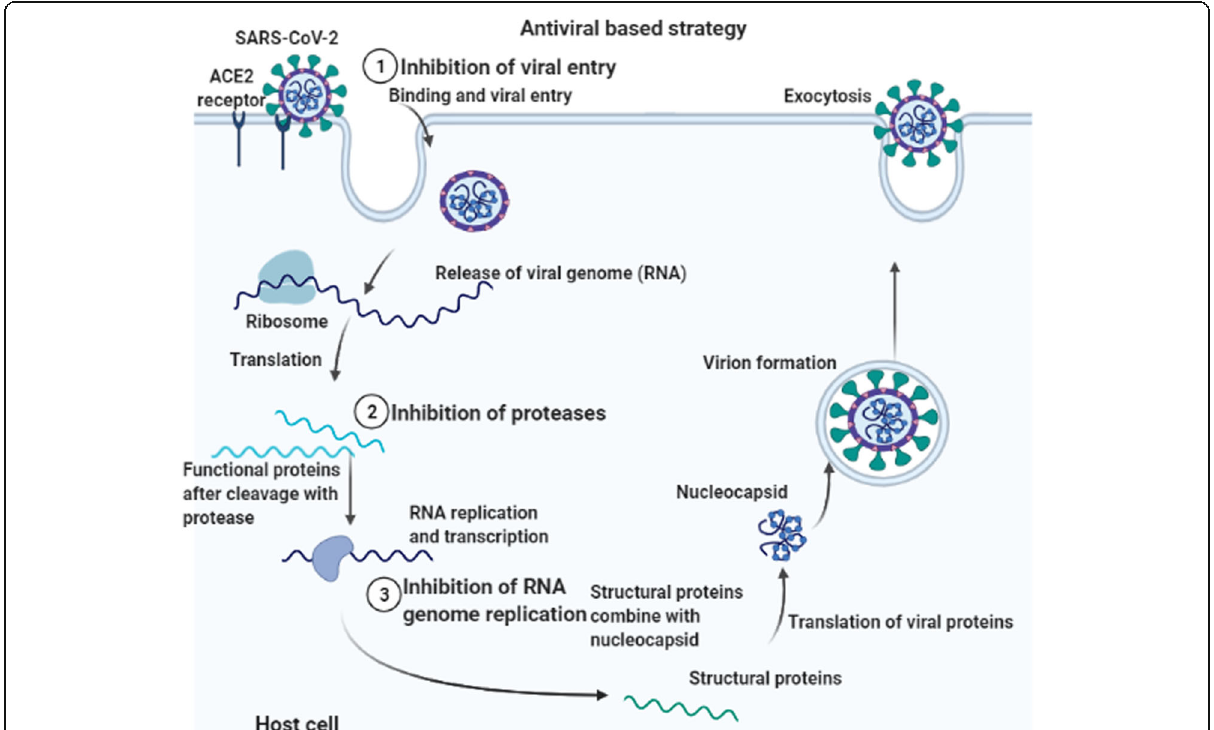
Fig. 1 Targets for antiviral drugs currently available treatment for COVID-19 combined with immune modulatory agents and